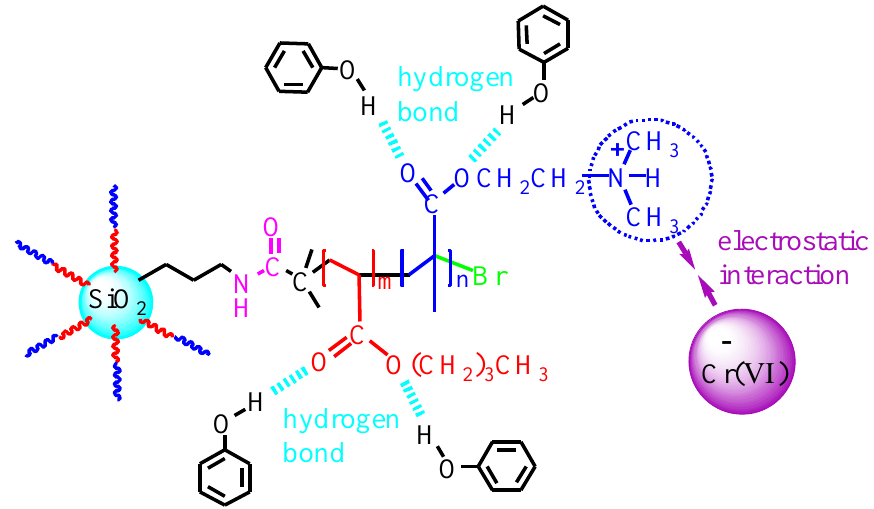
Figure 11. The proposed mechanisms for Cr( Ⅵ ) and phenol adsorption.